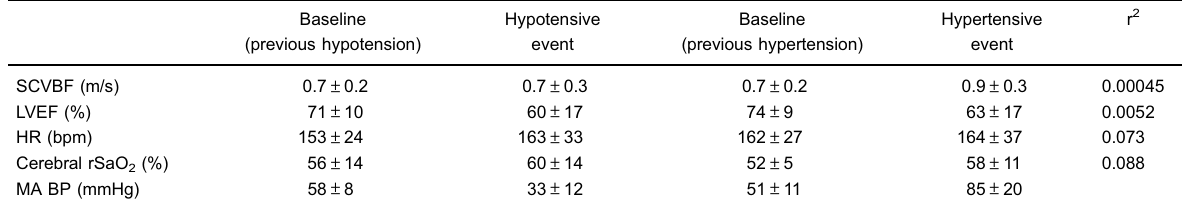
Table 1. Changes after modi fi cation of the systemic arterial pressure (SAP) including responses of superior cava vein blood fl ow (SCVBF), left ventricular ejection fraction (LVEF), heart rate (HR), and cerebral regional oxygen saturation (rSaO 2 ). Baseline Hypotensive Baseline (previous hypotension) event (previous